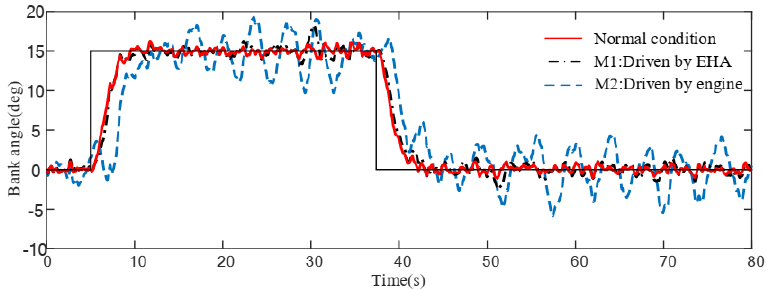
Figure 14. Bank angle response for damage scenario I under uncertainties and turbulences.